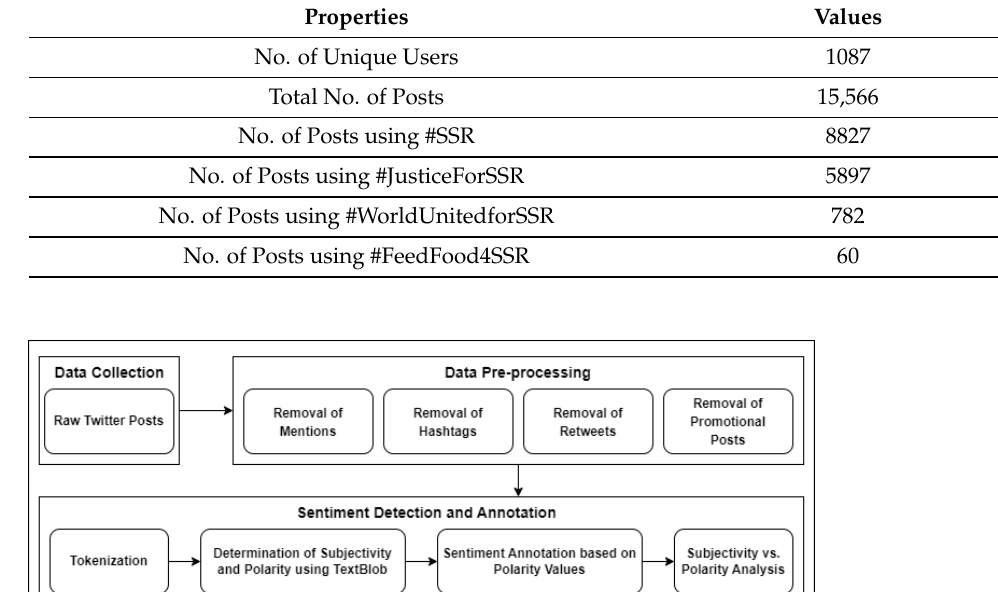
Table 2. Statistics of the dataset after pre-processing.